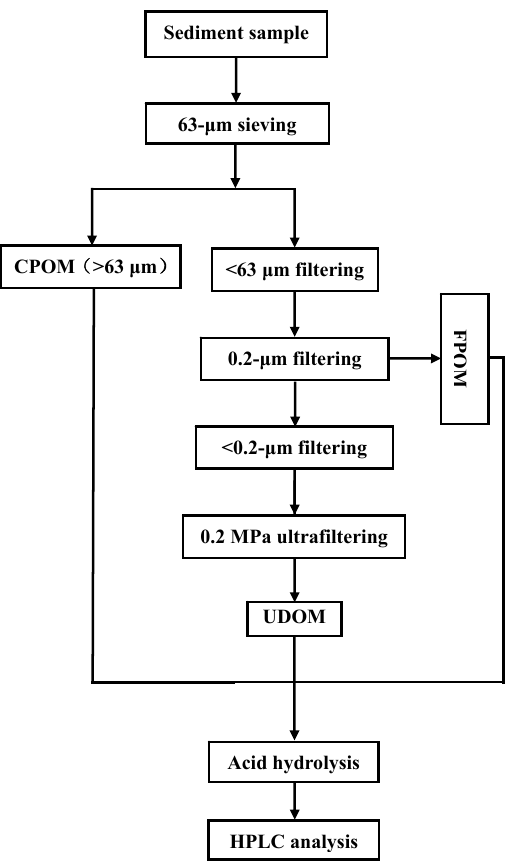
Fig. 2. Schematic graph for sediment fractionation procedure, in which CPOM is for coarse particulate organic matter, FPOM for fine particulate organic matter, and UDOM for ultrafiltered dis- solved organic matter.